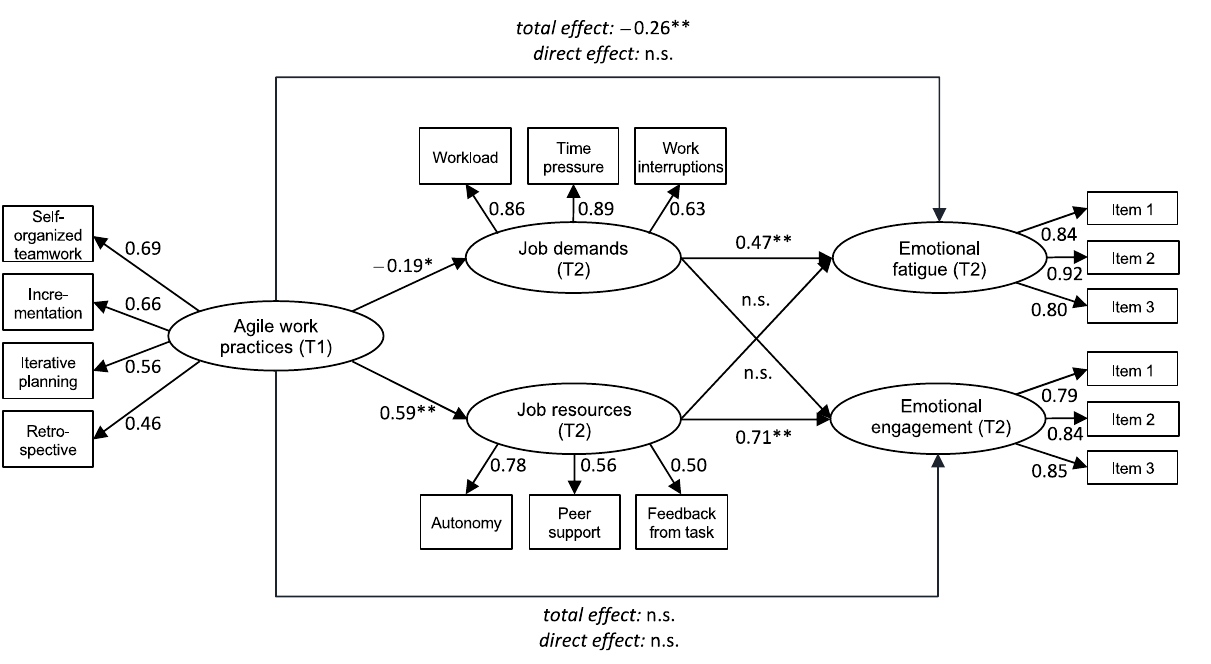
Figure 2. Structural equation model of the total, direct, and indirect effects of agile work practices, job demands, and job resources on emotional fatigue and emotional engagement (path coefficients are standardized. * p < 0.05, ** p < 0.01, n = 260).